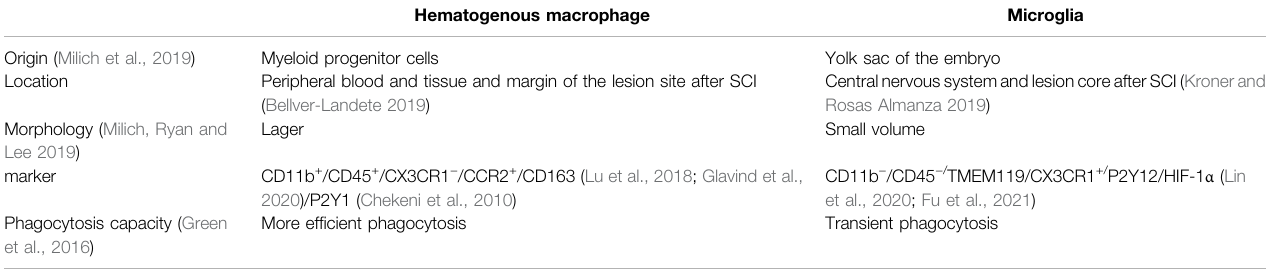
TABLE 1 | Distinction between hematogenous macrophage and